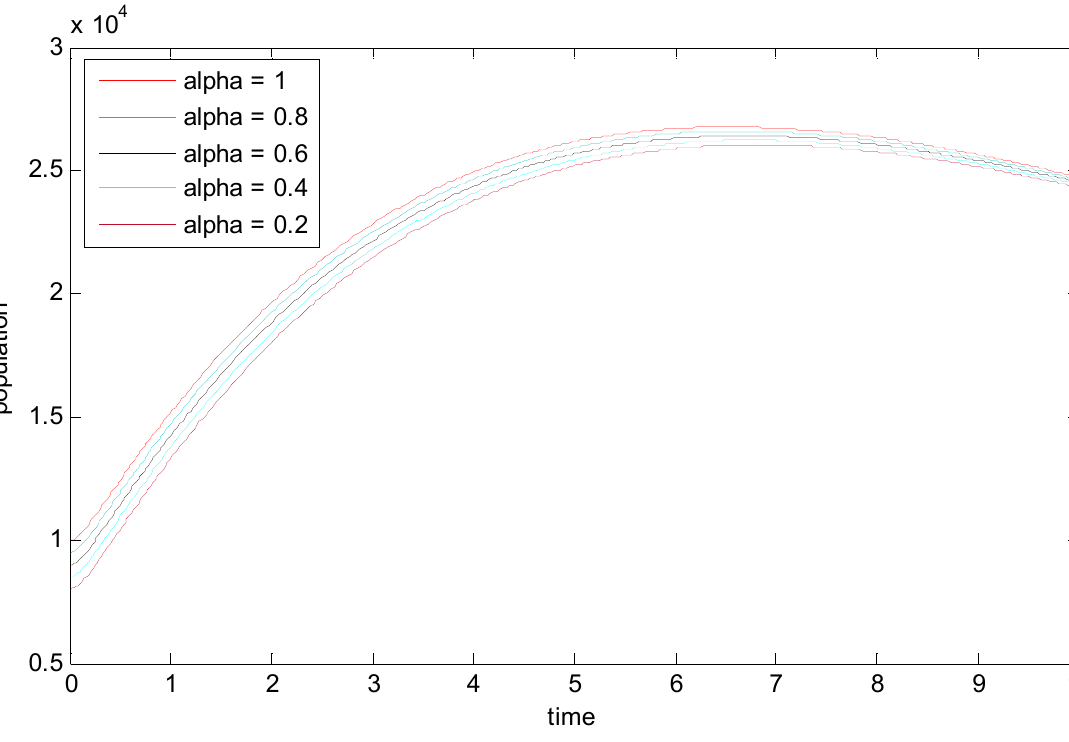
Figure 7. Dynamics of the infected population for various values of α .